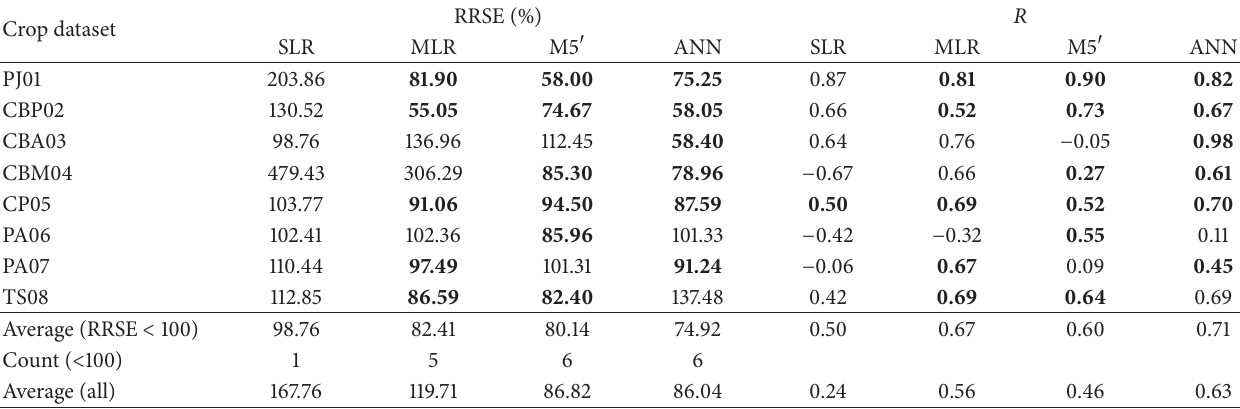
Table 8: RRSE and 𝑅 measures using the LAS on testing dataset.